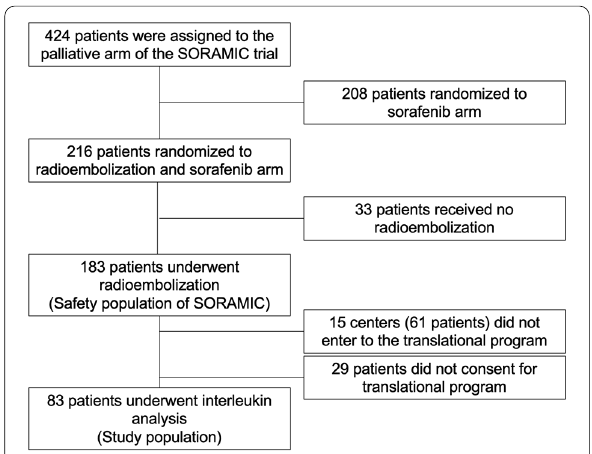
Fig. 1 Flowchart of the study population. A total of 83 patients were analyzed in this